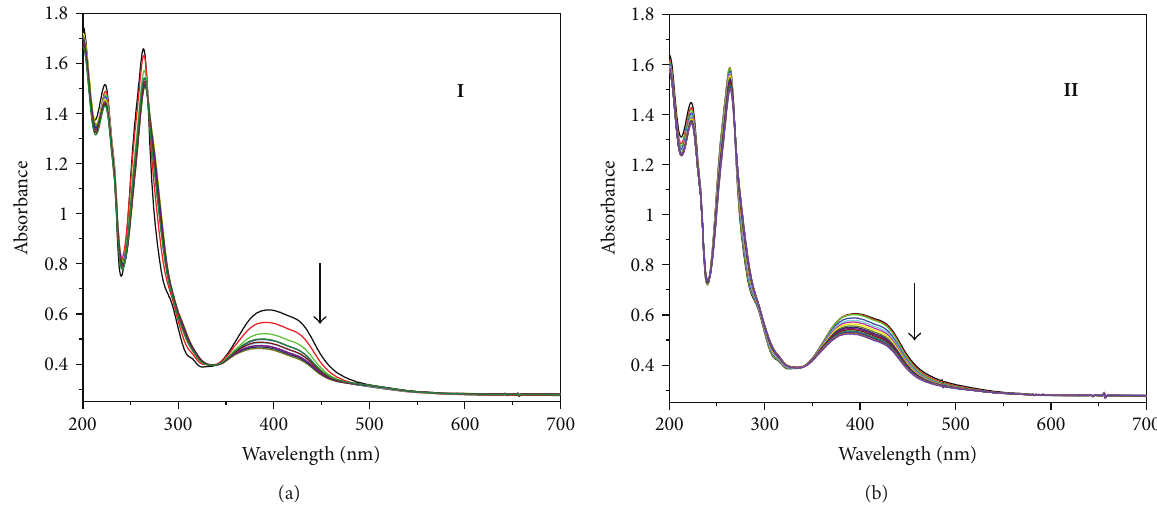
F 5: Spectroelectrochemical of complex I (1.5mM in